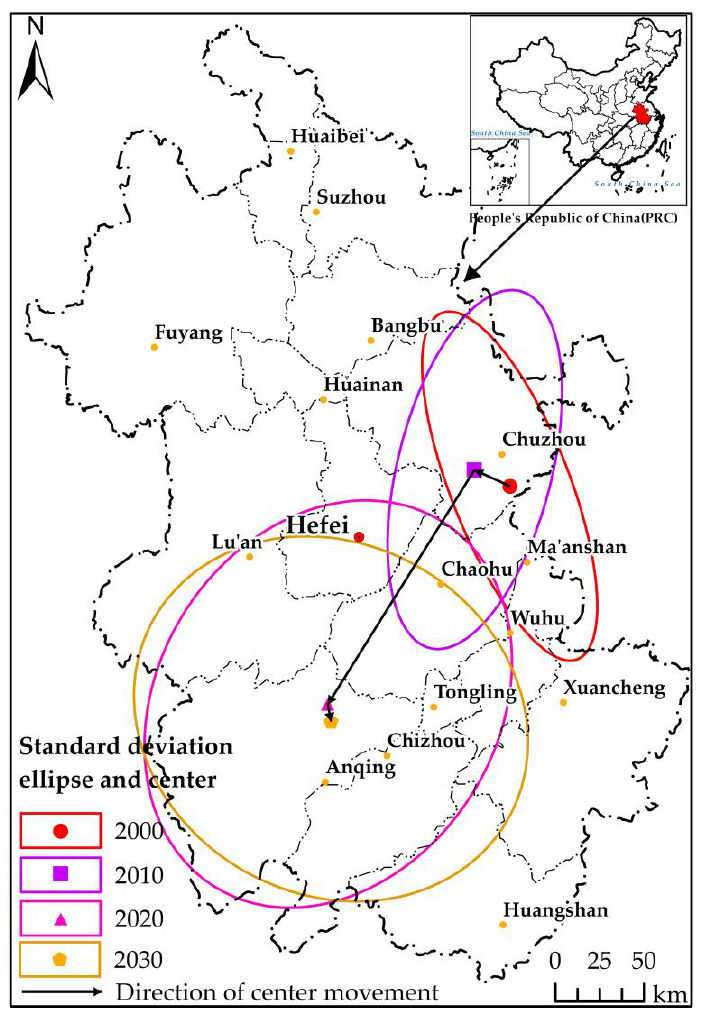
Figure 9. Map of directional distribution and center movement of PWD in different periods.